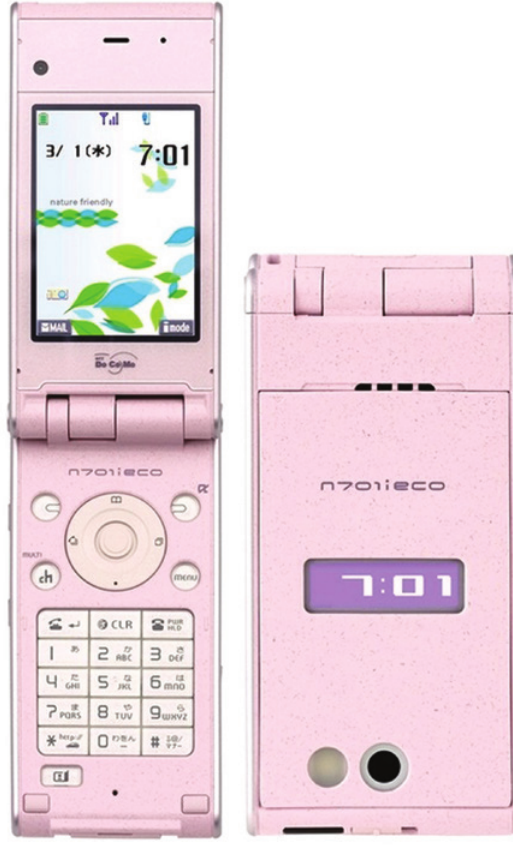
Figure 5: Bioplastic phone from NEC